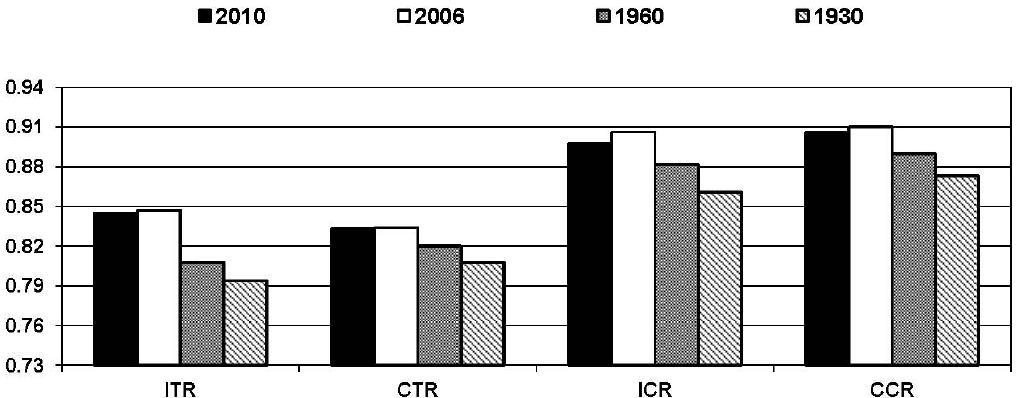
Figure 9. Heating systems global efficiency as the year